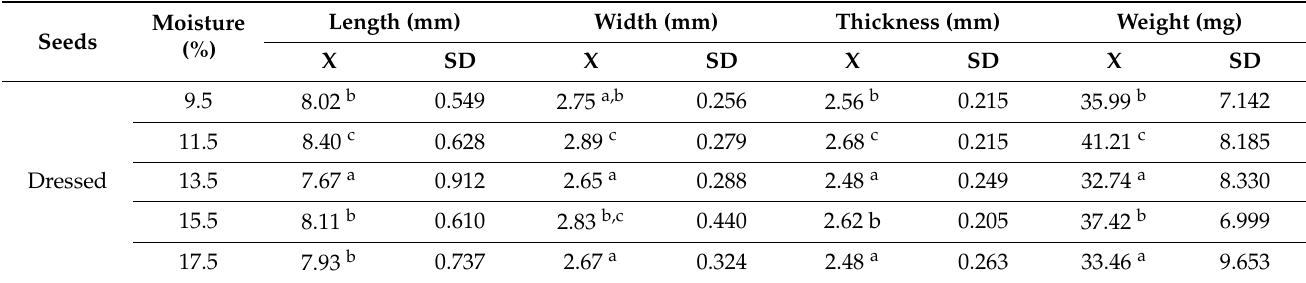
Table 1. The statistical parameters of the physical characteristics of winter triticale seeds.